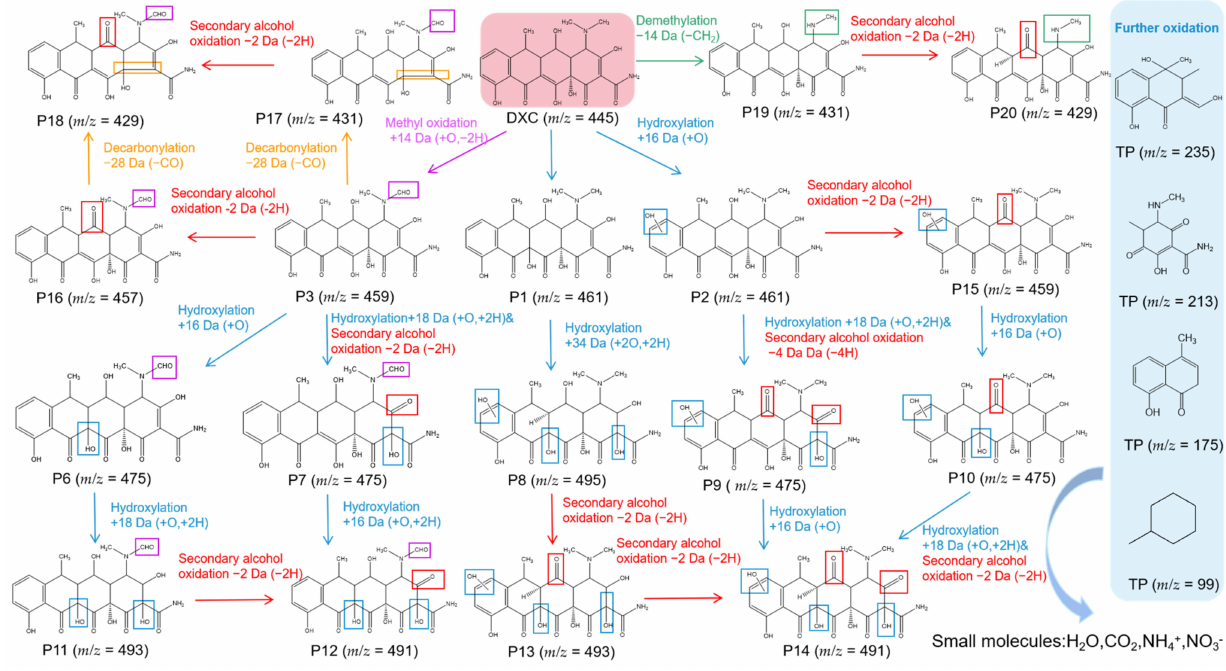
Figure 6. The proposed degradation pathways of DXC as catalyzed by F43Y/F138W/P88W